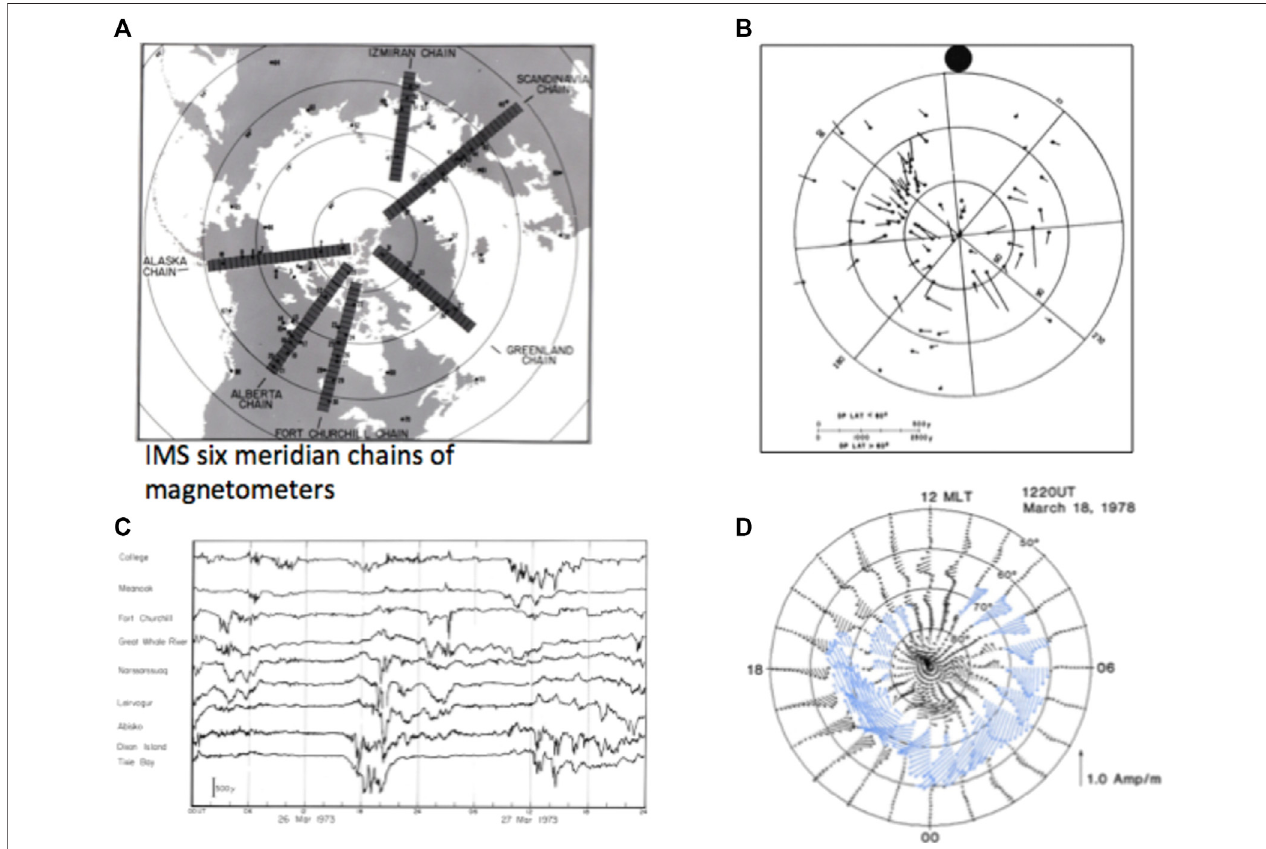
FIGURE12|(A) Thelocationofthesixmeridianmagneticstations. (B) Anexampleofmagneticrecords(theHcomponent)fromanumberofarcticstations. (C) An example of the distribution of disturbance vectors determined from the H and D components. (D) An example of electric current vectors; a special computer code was developed by Kamide et al. (1982) to convert the magnetic disturbance vectors into the current